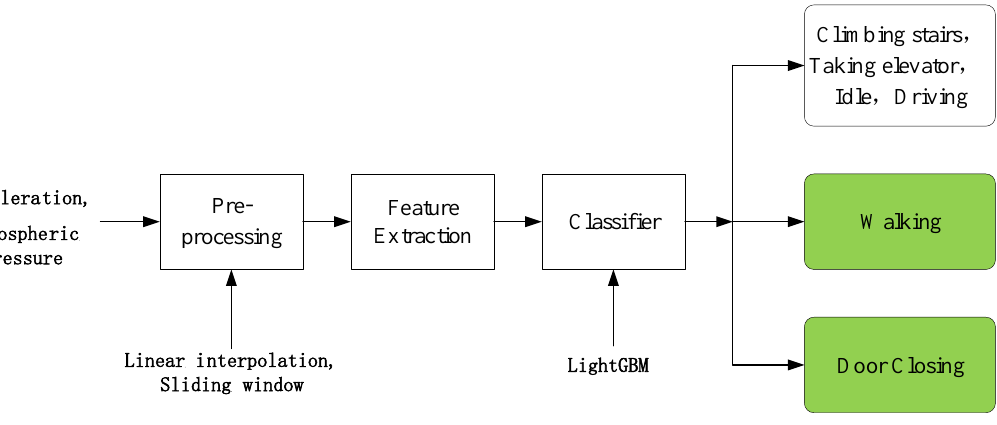
Figure 4. Overview of the UCD